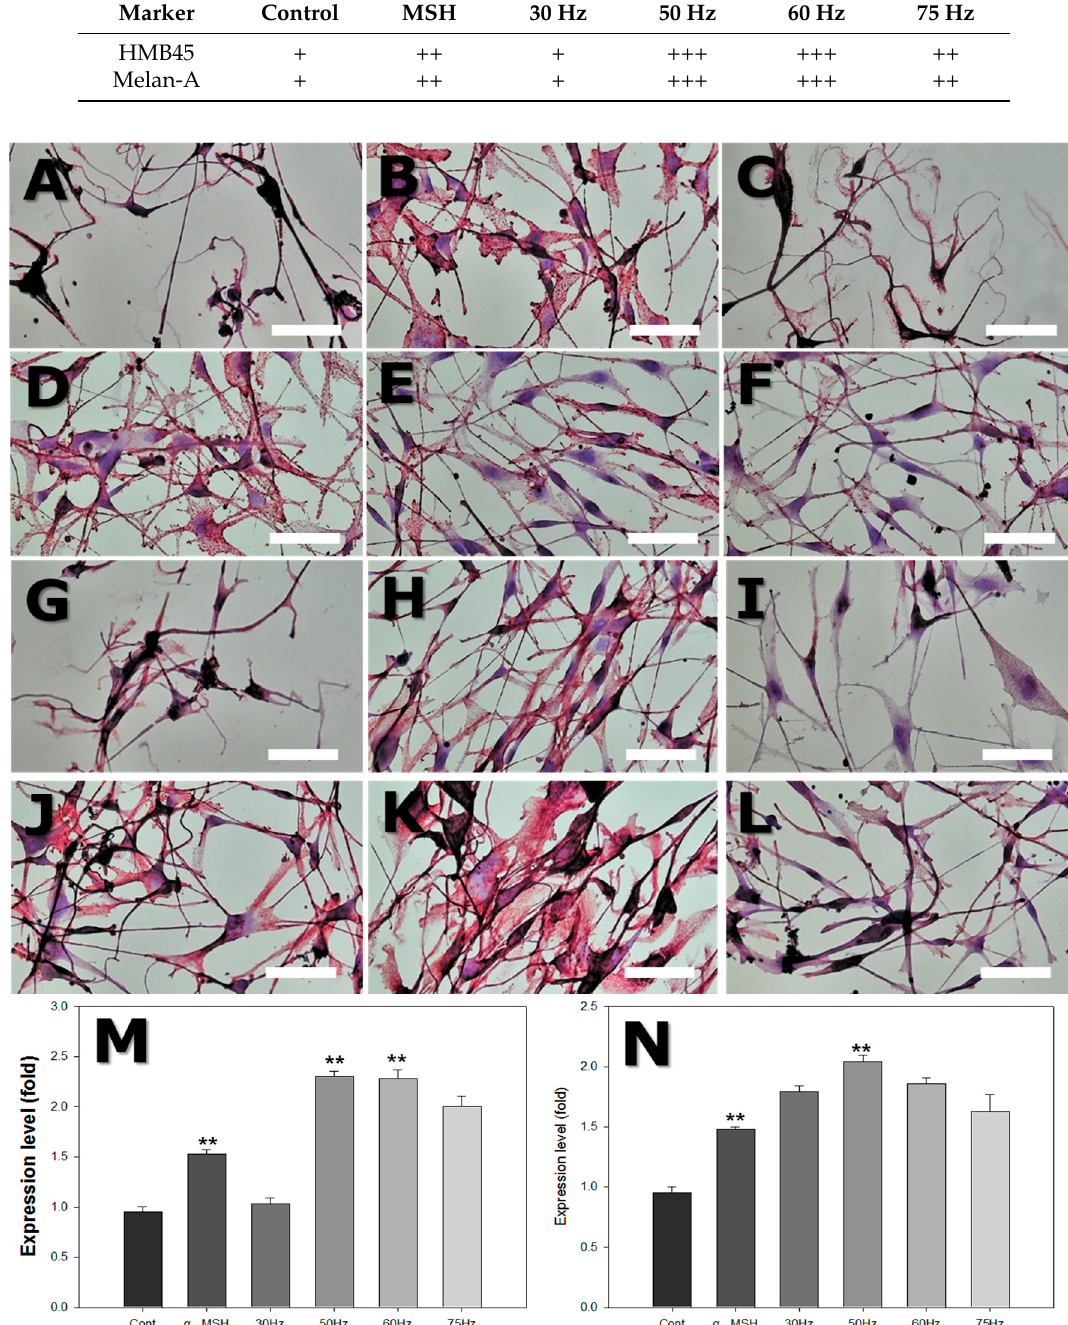
Figure 9. Light microscope photograph of human skin melanocytes attached to dish surface, stained with HMB45 and Melan-A after exposure to extremely low frequency electromagnetic field (ELF-EMF) for 72 h. ( A – F ) with HMB45 staining: ( A ) Control (Cont); ( B ) alpha-melanocyte-stimulating hormone ( α -MSH); ( C ) 30 Hz; ( D ) 50 Hz; ( E ) 60 Hz; and ( F ) 75 Hz. ( G – L ) with Melan-A staining: ( G ) Control; ( H ) α -MSH; ( I ) 30 Hz; ( J ) 50 Hz; ( K ) 60 Hz; and ( L ) 75 Hz. Original magnification was ×400; bar = 50 µ m. Quantitative analysis of expression levels of HMB45 ( M ) and Melan-A ( N ) after ELF-EMFs exposure. Each bar represents the mean ± standard error of independent experiments performed in triplicate ( n = 4). ** p < 0.01, compared to the control.